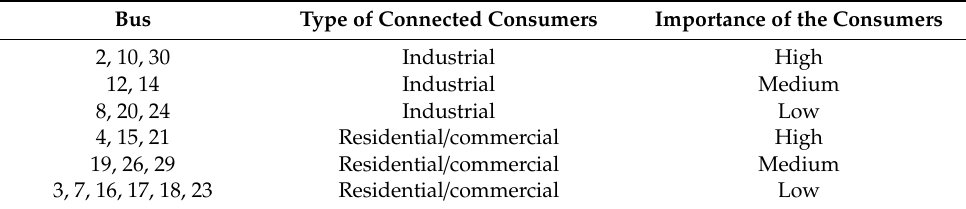
Table 3. Importance and Type of the Consumers Connected to Each